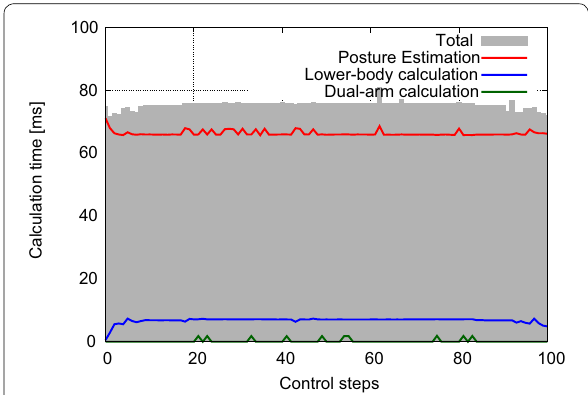
Fig. 7 The calculation time of SVR, lower-body IK and both arms IK.